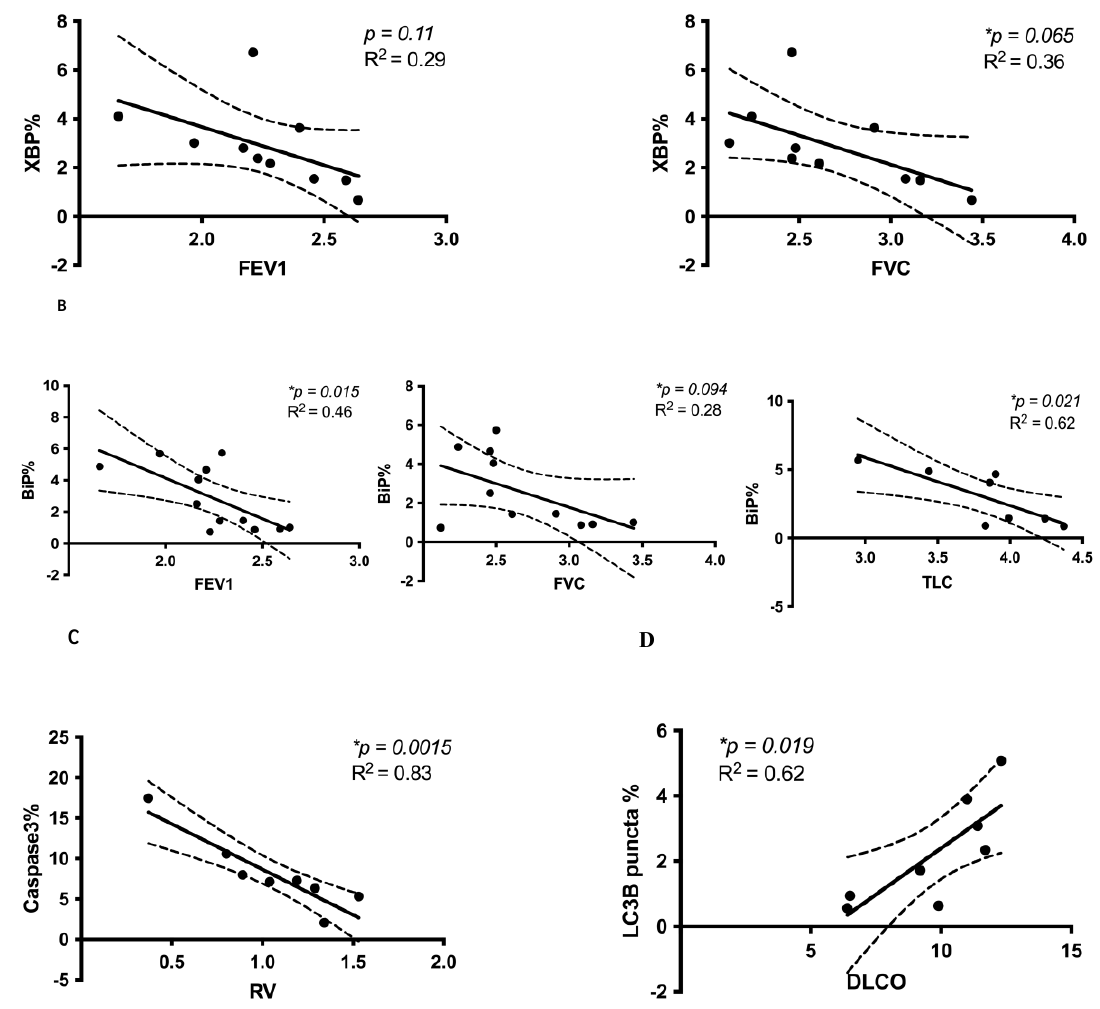
Figure 2. Correlations between cell stress markers and lung function in IPF. ( A ) The UPR marker XBP1% was negatively correlated with FEV1 and FVC. There was a trend of negative correlation between XBP1% and FEV1 ( p = 0.11, R 2 = 0.29) and a statistically significant negative correlation between XBP1% and FVC ( p = 0.065, R 2 = 0.36). ( B ) The UPR marker BiP% was negatively correlated with FEV1 ( p = 0.015, R 2 = 0.46), FVC ( p = 0.094, R 2 = 0.28), and TLC (* p = 0.021, R 2 = 0.62). ( C ) The apoptosis marker cleaved caspase-3% was also negatively correlated with RV ( p = 0.0015, R 2 = 0.83). ( D ) The autophagy marker LC3 β puncta% was positively correlated with DLCO ( p = 0.019, R 2 = 0.62). Confidence intervals are included, shown by the dotted curved lines flanking the regression line. Linear regression analyses were performed using GraphPad Prism 9. Lung volumes (FEV1, FVC, RV, TLC) were measured in liters, and the diffusion capacity of carbon monoxide (DLCO) was measured in mL/mmHg/min. * reprents the significant difference. We then assessed correlations between co-localized UPR, autophagy, and apoptosis markers. We also hypothesized that co-localized markers of UPR and autophagy in IPF lung tissues would correlate with lower lung function values, similar to our XBP1, BiP, and cleaved caspase-3 results. However, we found that the opposite was true. Higher immunofluorescence of overlapping markers XBP1 and LC3 puncta was consistently associated with significantly greater FEV1, FVC, and TLC (Figure 3A,B). Higher immu- nofluorescence of overlapping markers BiP and LC3 puncta was associated with sig- nificantly increased DLCO ( p = 0.0067) (Figure 3C). However, co-localized LC3 puncta and BiP were not significantly correlated with any lung function parameters ( p > 0.1) (data not shown). There were no statistically significant correlations between overlap-